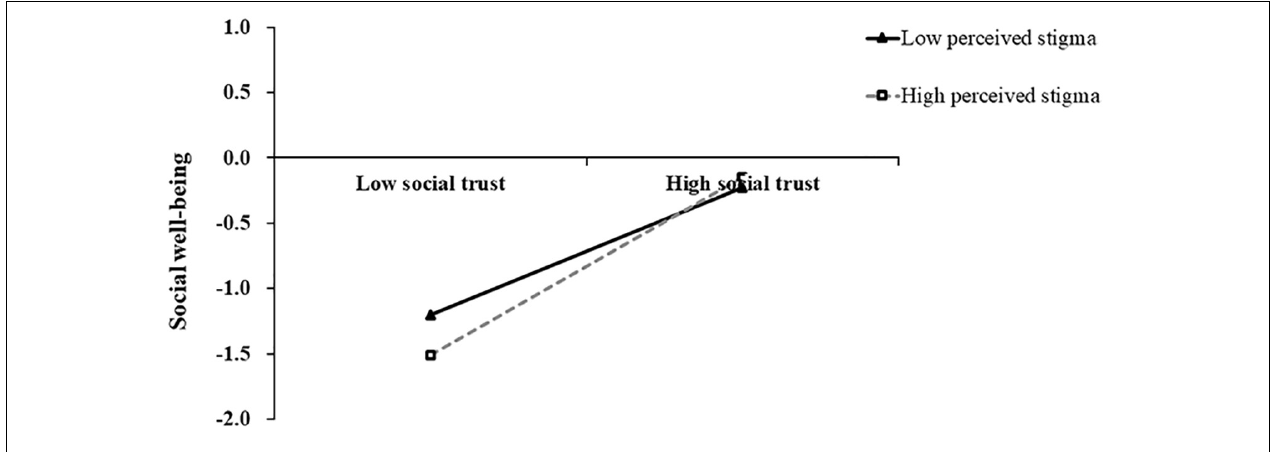
FIGURE 3 | The moderating effect of perceived stigma on the relationship between social trust and social well-being.